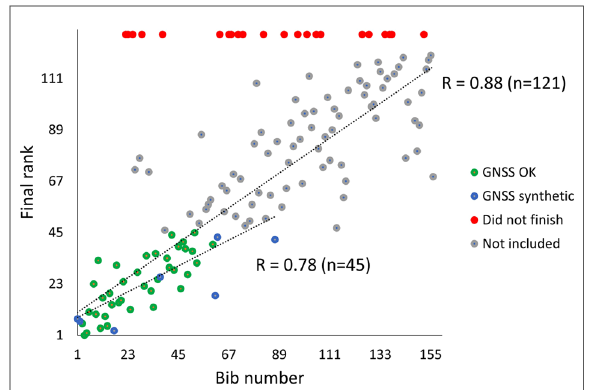
FIGURE 3 Final rank as a function of starting position (i.e bib number set by FIS distance points) in a 21.8 km cross-country skiing mass-start competition. The included skiers with adequate quality GNSS signals (GNSS OK) are visualised in green, skiers with synthetic speed pro fi les derived from a deep learning model explained in the methods section (GNSS synthetic) in blue, the skiers who did not fi nish in red and those not included in